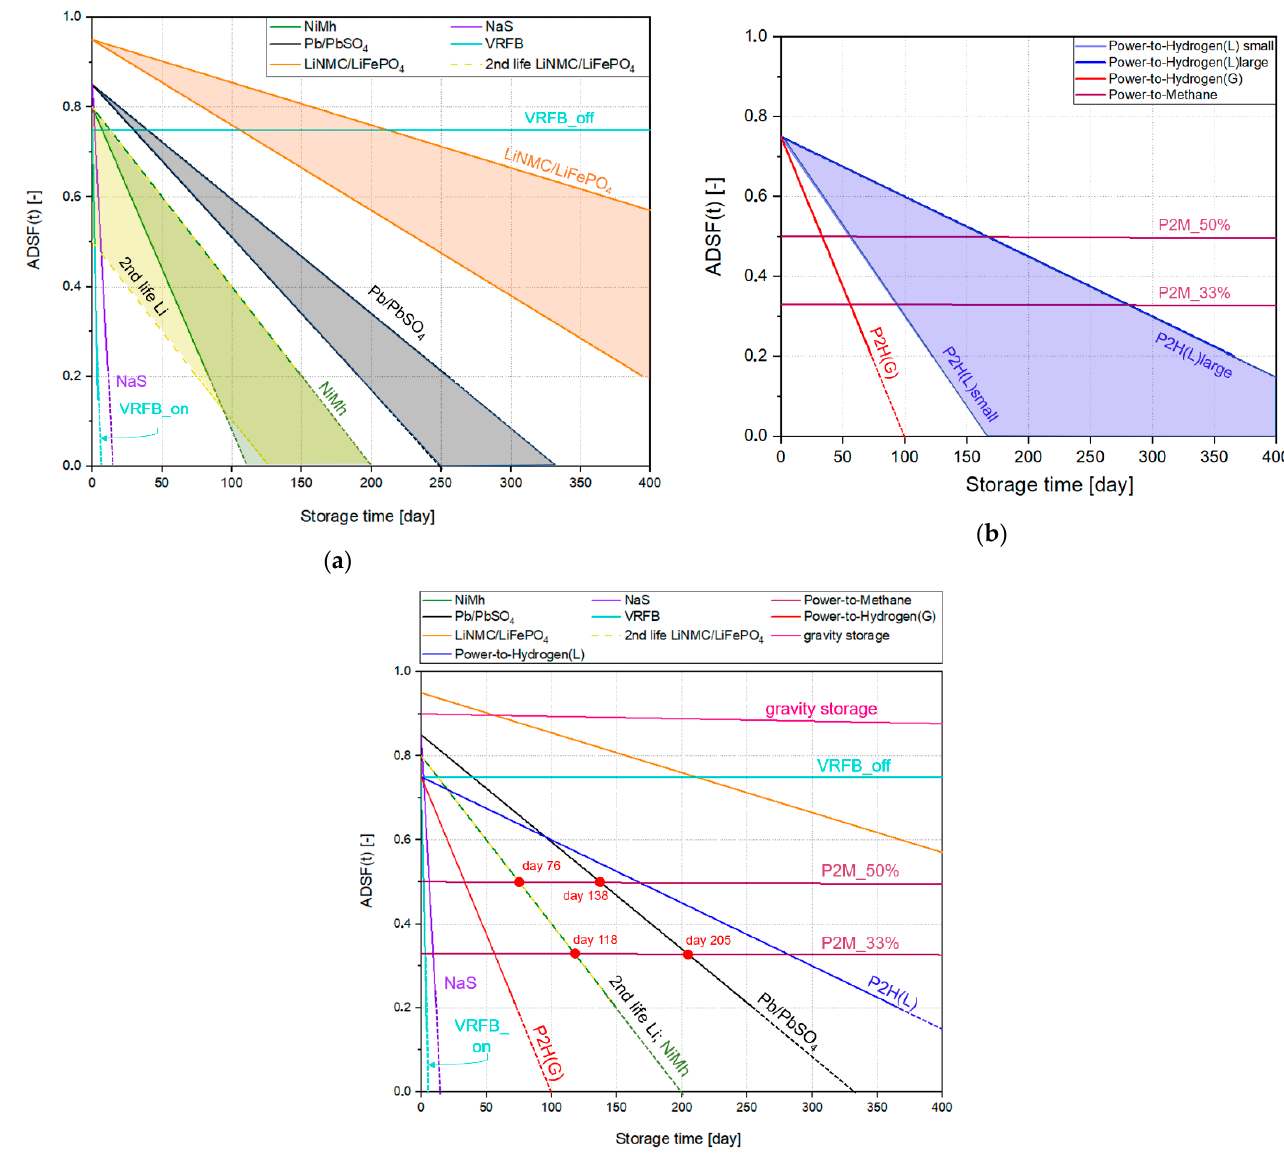
Figure 5. Comparison of simplified (linear) ADSF ( t ) functions of the relevant storage methods. ( a ): Comparison of various battery types (marking the best and worst scenarios); ( b ): Similar diagram for the available Power-to-Gas methods; ( c ): comparison of the methods using data of the best commercially available models. The intersection points indicate which storage method is energetically better for storage times shorter than the corresponding duration or longer than the corresponding no-load storage time. The four red dots indicate the times for which the Power-to-Methane method may be energetically good for longer duration storage.